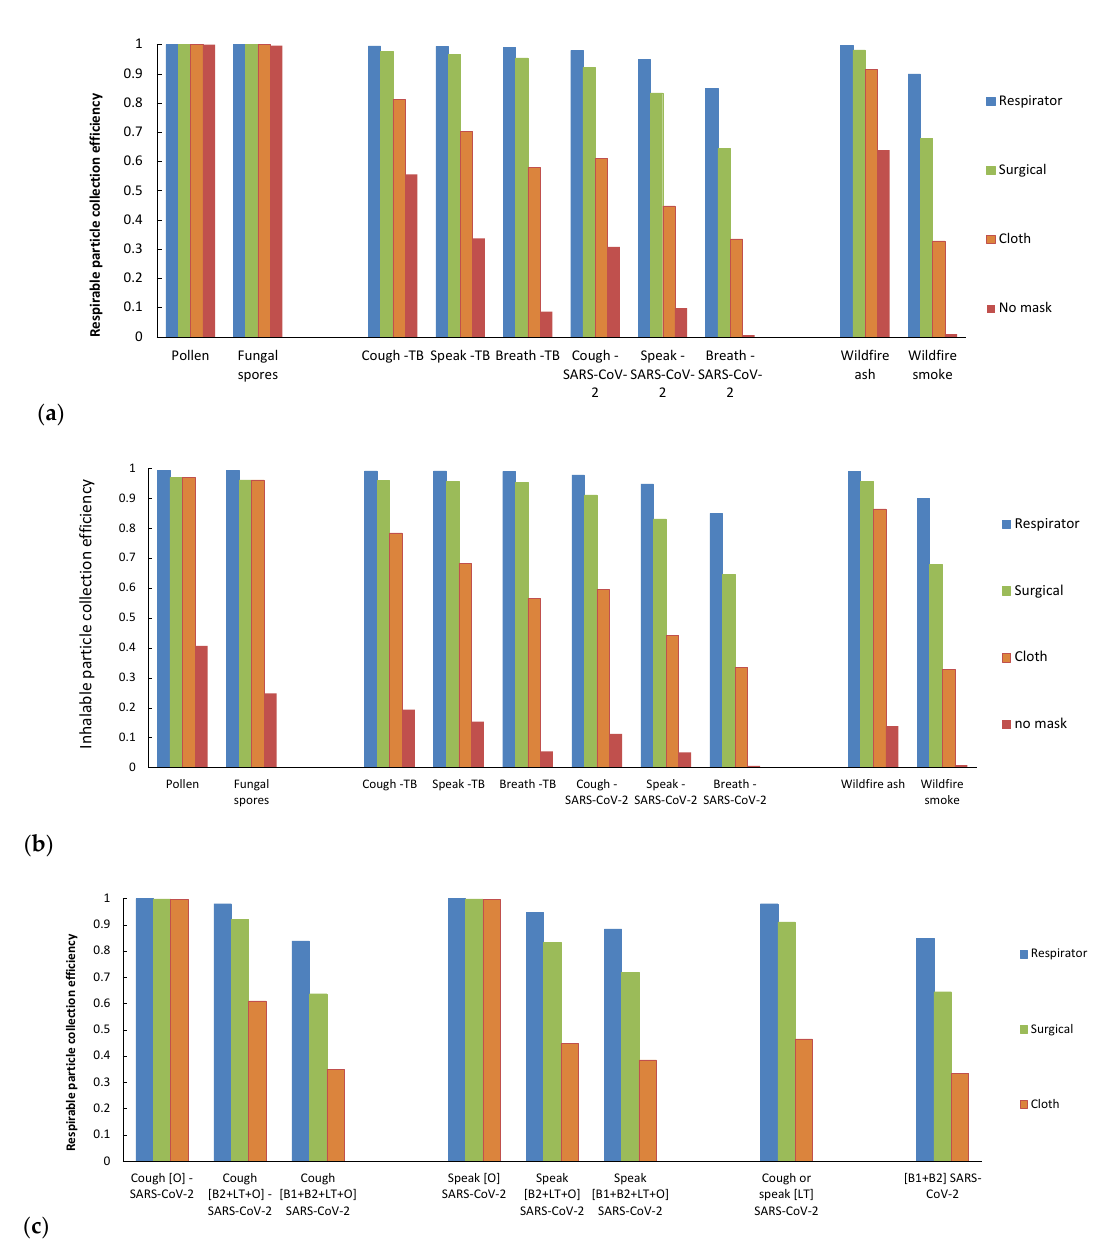
Figure 3. Predicted collection efficiency E tot for ( a ) respirable particle deposition and respirator, surgical, cloth, or no masks for various aerosol types; ( b ) the same as ( a ) but for inhalable deposition, and ( c ) human-emitted particles with infectious SARS-CoV-2 generated at various combinations of organ locations for the three mask types.